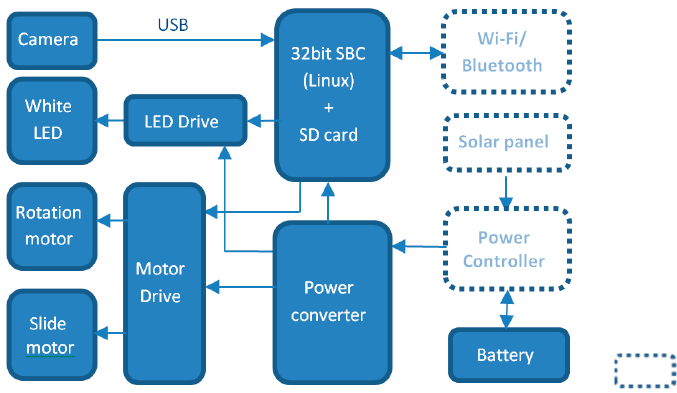
Figure 4. Hardware block diagram of the SoilCam.